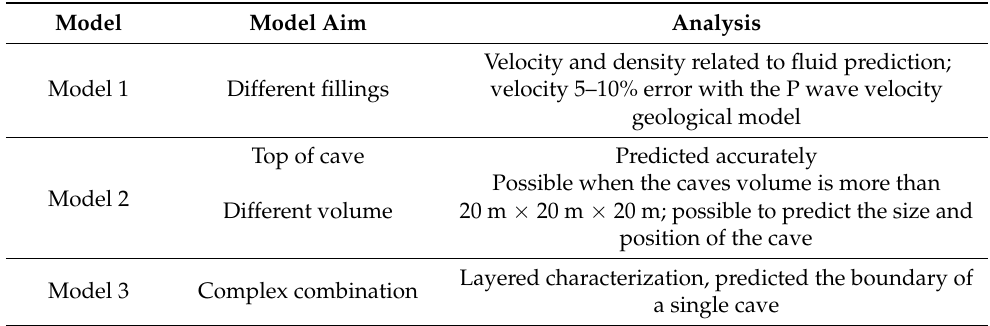
Table 3. Quantitative analysis results of pre-stack inversion.